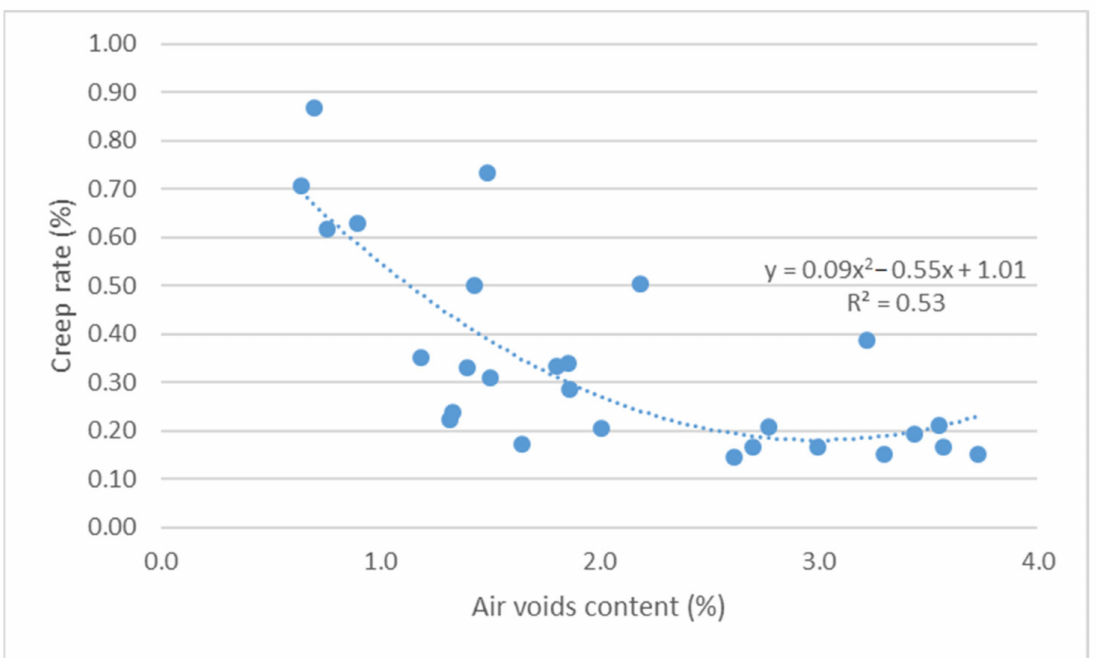
Figure 10. Creep rate vs. air void